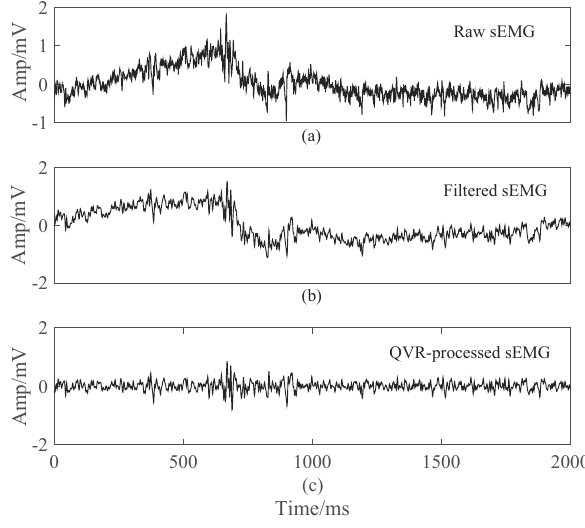
Figure 3. Preprocessing of sEMG. ( a ) An example of raw sEMG, corresponding to channel 2 in Figure 2; ( b ) The sEMG filtered by Butterworth (0.15 ∼ 300 Hz) and notch (50 Hz) filters; ( c ) Quadratic Variation Reduction (QVR)-processed sEMG, where the most amplitude change is less than 1